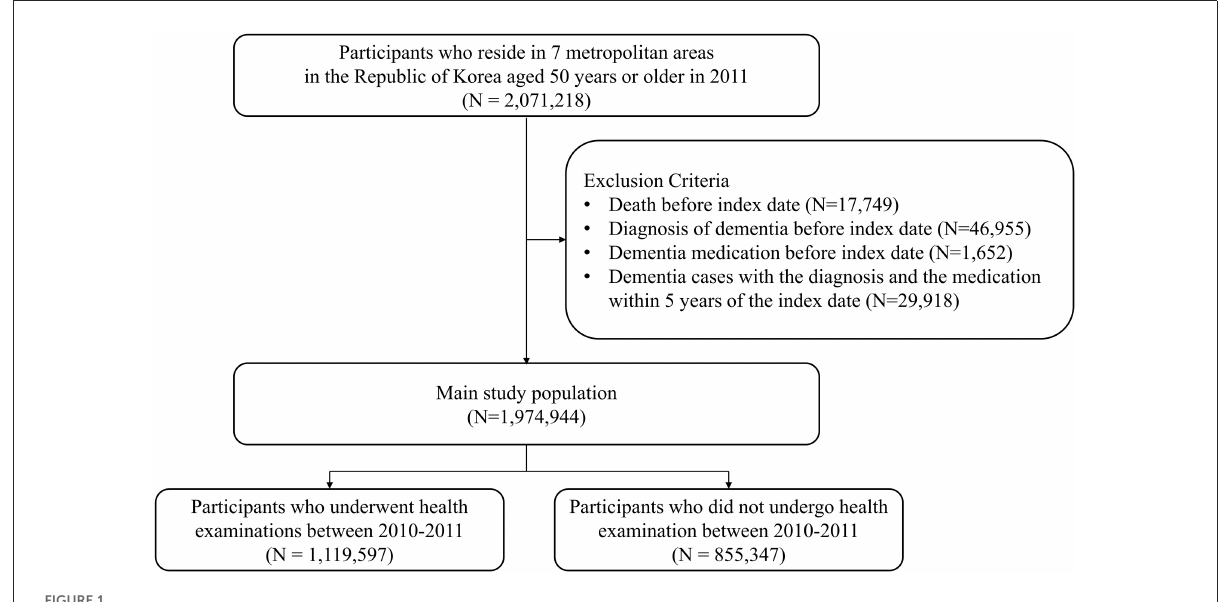
FIGURE1 Study sample